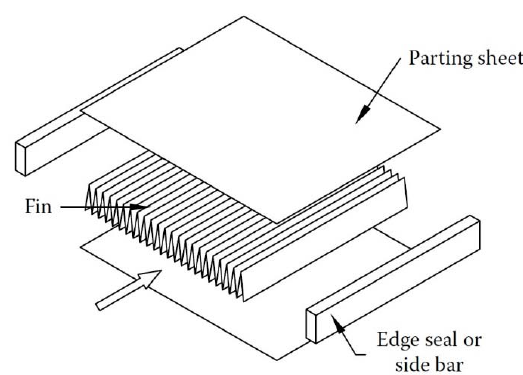
Figure 3. A schematic view of di ff erent elements of a plate-fin heat exchanger (PFHE) [49].